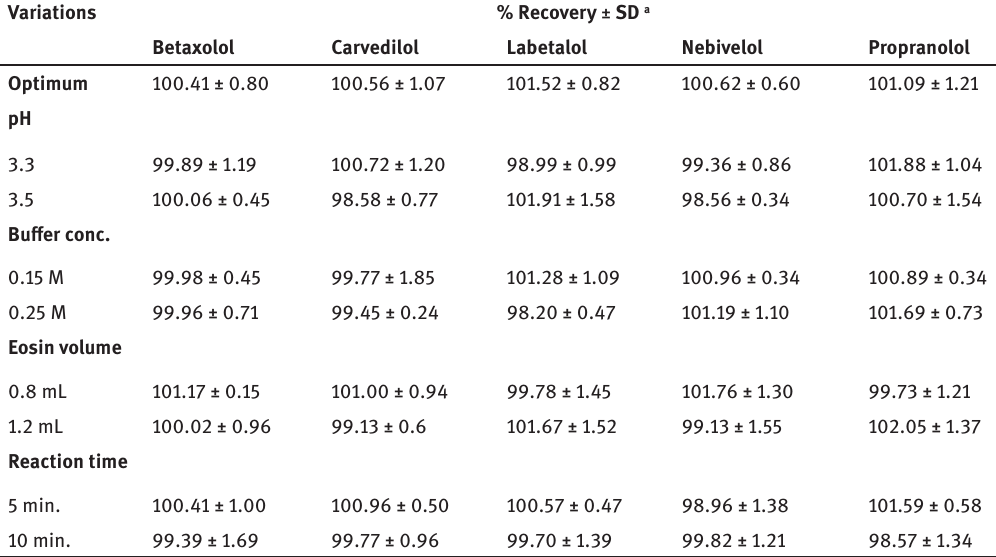
Table 4: Robustness of the proposed method for determination of the studied drugs (1.0 µg mL -1 ).